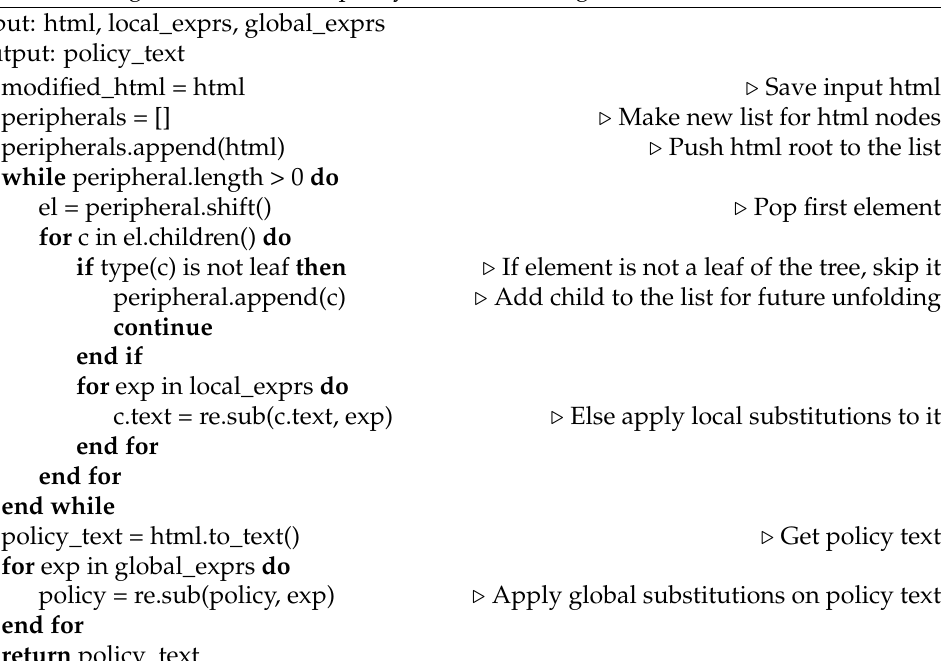
Algorithm 4 Algorithm of extract_policy function cutting all available text in HTML